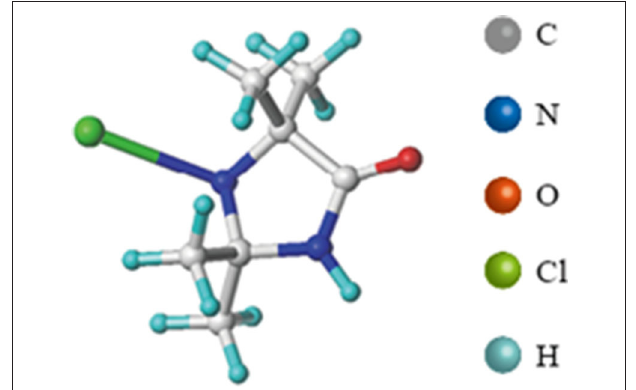
FIGURE 1 | Structure of MC